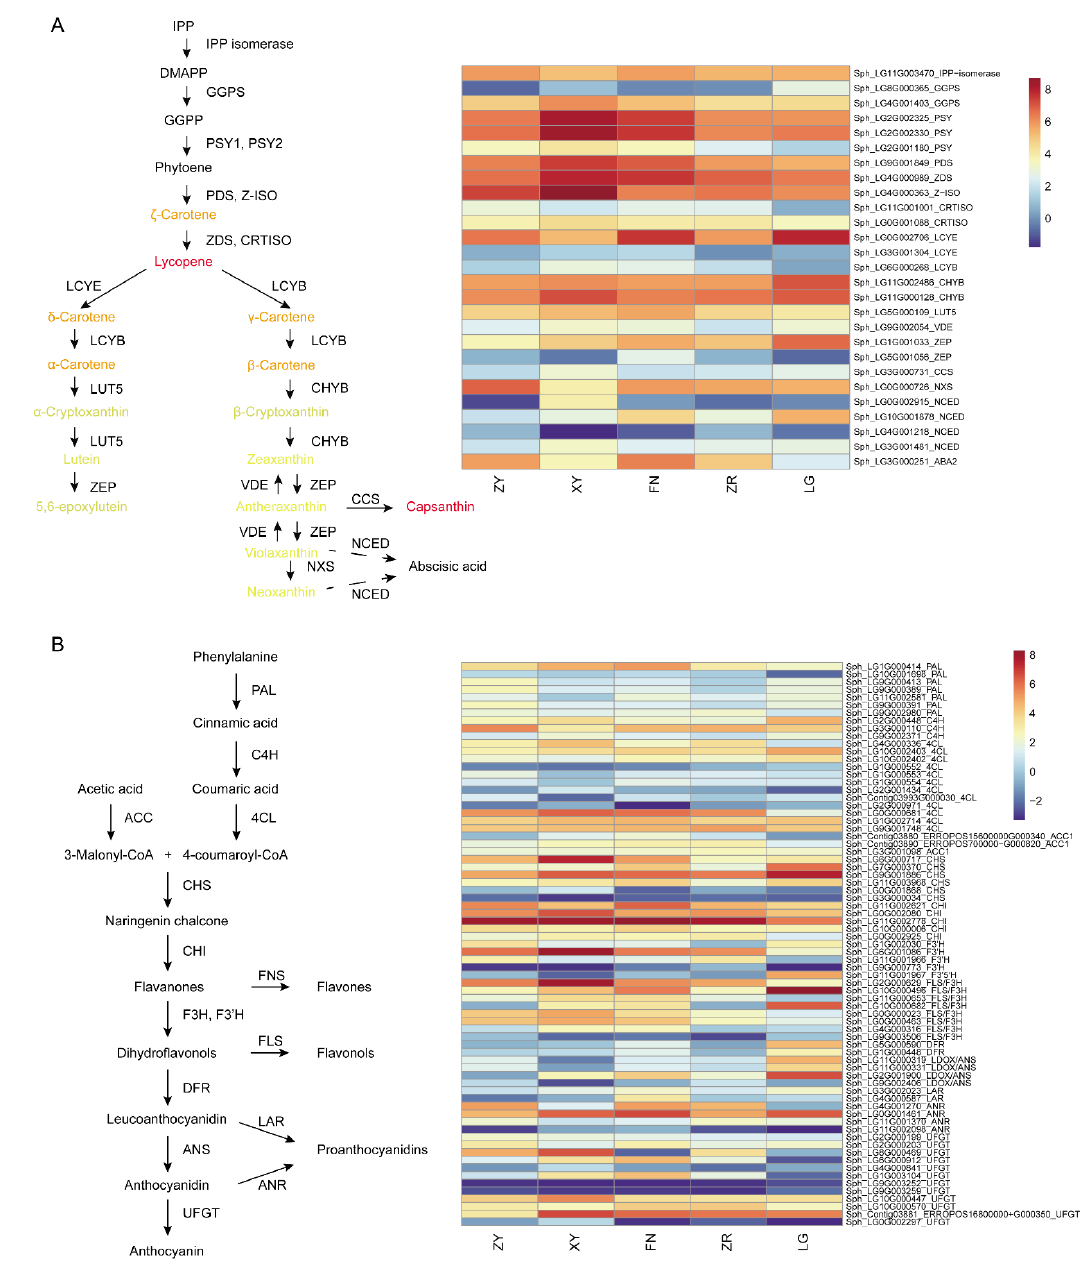
Figure 6. Carotenoid and flavonoid metabolism pathways and synthesis genes. ( A ) Carotenoid metabolism pathways and synthesis genes. IPP, isopentenyl diphosphate; DMAPP, dimethylallyl pyrophosphate; GGPP, geranylgeranyl diphosphate; GGPS , GGPP synthase; PSY , phytoene synthase; PDS , phytoene desaturase; Z-ISO , ζ -carotene isomerase; ZDS , ζ -carotene desaturase; CRTISO , carotenoid isomerase; LCYE , lycopene ε -cyclase; LCYB , lycopene β -cyclase; CHYB , β -carotene hydroxylase; LUT5, Lutein deficient 5; ZEP , zeaxanthin epoxidase; VDE , violaxanthin de-epoxidase; CCS , capsanthin–capsorubin synthase; NXS , neoxanthin synthase; NCED , 9-cis-epoxycarotenoid dioxygenase. ( B ) Flavonoid metabolism pathways and synthesis genes. PAL , phenylalanine ammonia lyase; C4H , cinnamate 4-hydroxylase; 4CL , 4-coumarate-CoA ligase; ACC1 , acetyl-CoA carboxylase 1; CHS , chalcone synthase; CHI , chalcone isomerase; F3H , flavanone 3-hydroxylase; F3 (cid:48) H , flavonoid 3 (cid:48) -hydroxylase; DFR , dihydroflavonol 4-reductase; ANS , anthocyanidin synthase; UFGT , flavonoid- 3-O-glucosyltransferase; FNS , flavone synthase; FLS , flavonol synthase; LAR , leucoanthocyanidin reductase; ANR , anthocyanidin reductase. The pathway is constructed based on KEGG pathway and references. Heat maps of gene expression levels based on FPKM